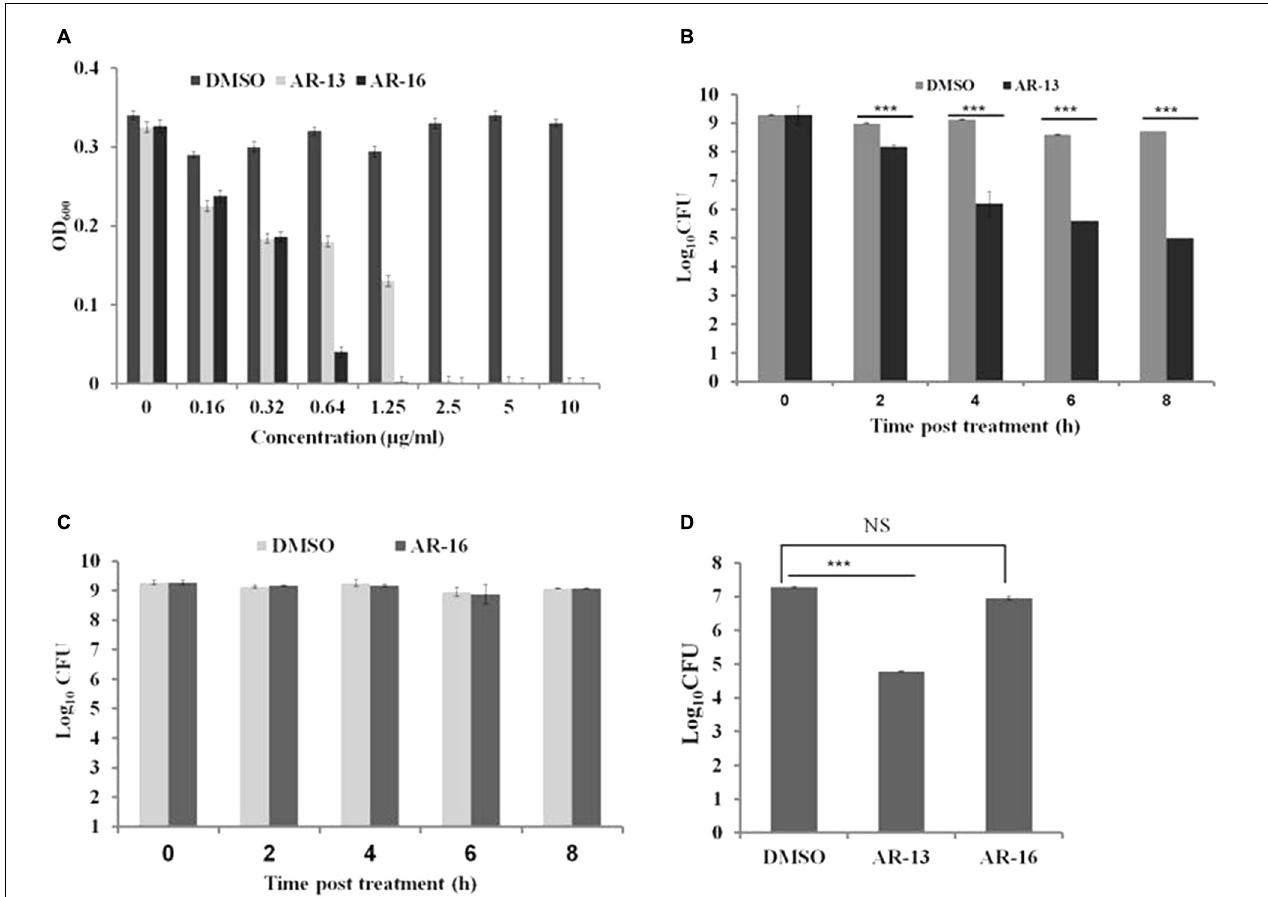
FIGURE 2 | Susceptibilities of Francisella tularensis to AR-13 and AR-16. (A) LVS was grown in twofold serial dilutions of AR-13 and AR-16 in mTSB. Optical densities at 600nm (OD 600 ) were measured by a plate reader 18 h after inoculation. (B) AR-13 has a bactericidal effect on LVS. Approximately 1.5 × 10 9 CFU were incubated in 1 ml PBS containing 10 µ g of AR-13. Viable bacteria were evaluated at different time points by serial dilution and plating. (C) AR-16 has a bacteriostatic effect on LVS. Approximately 1.5 × 10 9 CFU were incubated in 1 ml PBS containing 10 µ g of AR-16. Viable bacteria were evaluated at different time-points by serial dilution and plating. (D) AR-13 and AR-16 have bactericidal and bacteriostatic effects, respectively, on F. tularensis SchuS4. Approximately 1.5 × 10 9 CFU of F. tularensis SchuS4 was incubated in 1 ml PBS containing 10 µ g of AR-13 or AR-16. Viable bacteria were evaluated at 8 h post-treatment by serial dilution and plating. Data are representative of 2–4 independent experiments, each performed in triplicate; ∗∗∗ p < 0.001; NS, not